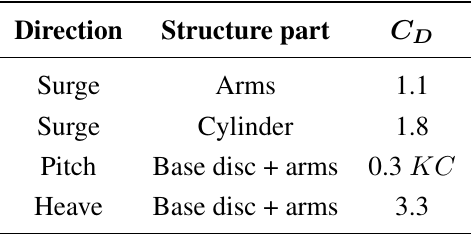
Table 2. Definition of applied drag coefficient